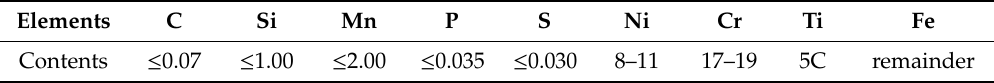
Table 1. Material elements and contents of stainless steel 0Cr18Ni9Ti slipper (wt.%).